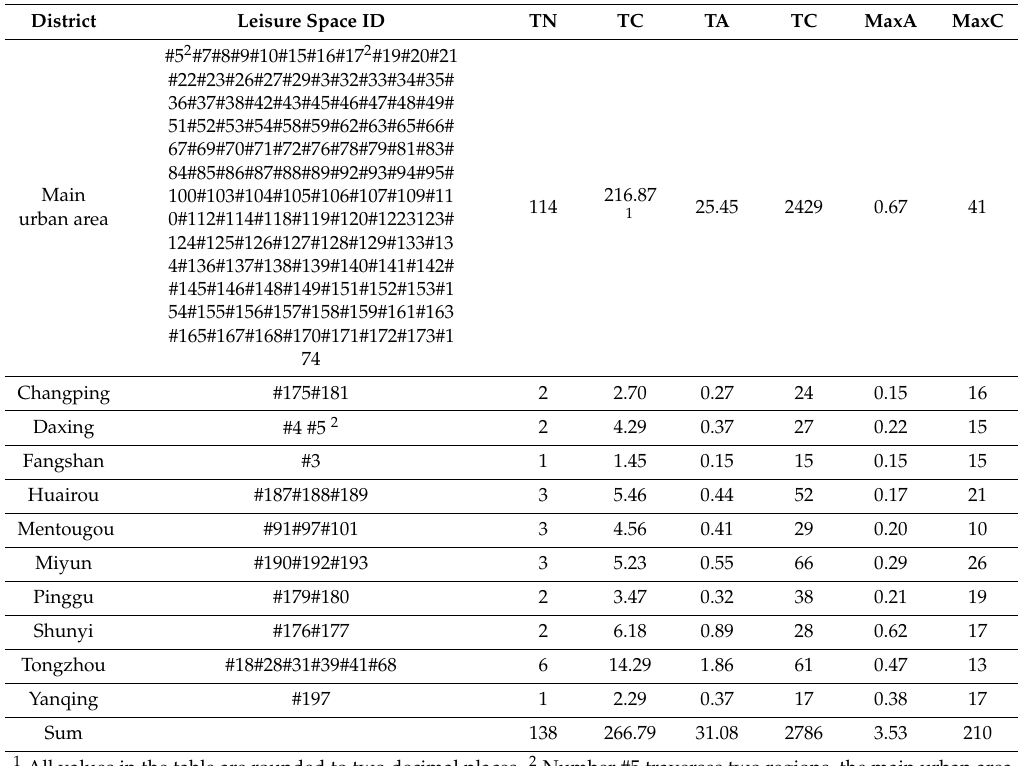
Table 5. Summary of the geometric and statistical attributes of the UNLSs.